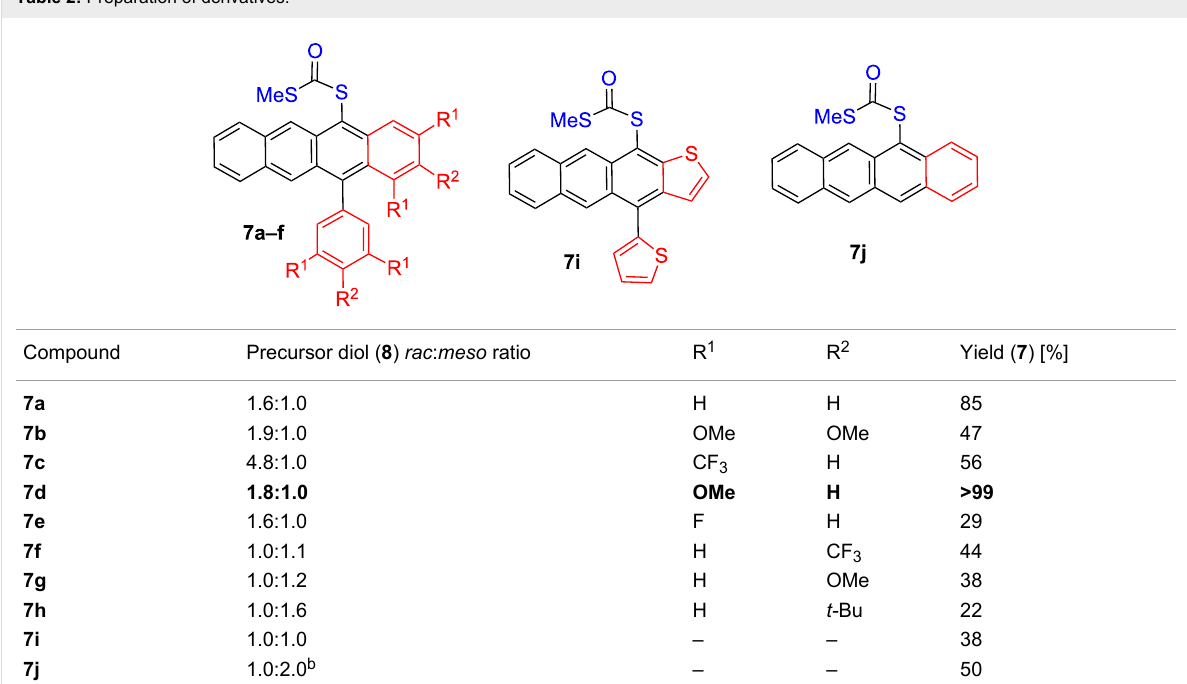
Table 2: Preparation of derivatives.